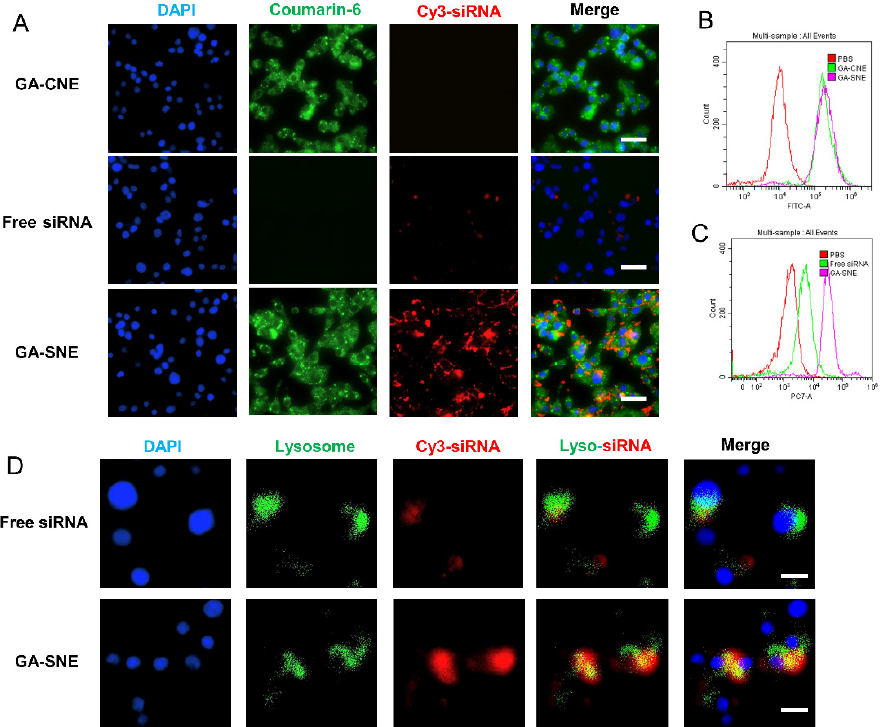
Figure 2. Cellular uptake of GA-CNE. ( A ) Confocal laser scanning microscopy (CLSM) images of cellular uptake with different treatments after 4 h. Scale bar: 50 µ m. ( B ) Cellular uptake of GA and ( C ) siRNA after 4 h of incubation was analyzed by flow cytometry. ( D ) Confocal laser scanning microscopy (CLSM) images of lysosomal escape with different treatments after 4 h. Scale bar: 20 µ m.